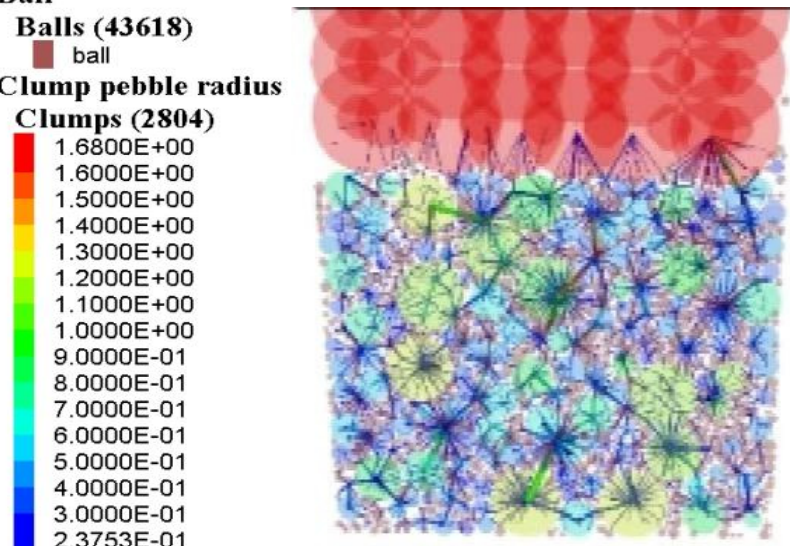
Figure 7. Force chain distribution and skeleton particle position. In the figure, E is abbreviation for exponent, for example, the number 1.68E3 stands for 1.68.